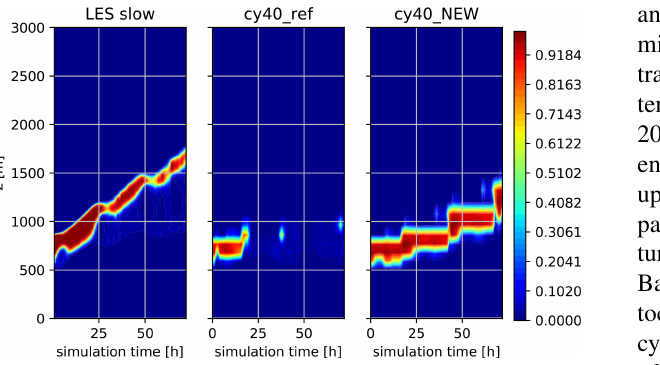
Figure 17. As Fig. 16 but for the slow case.